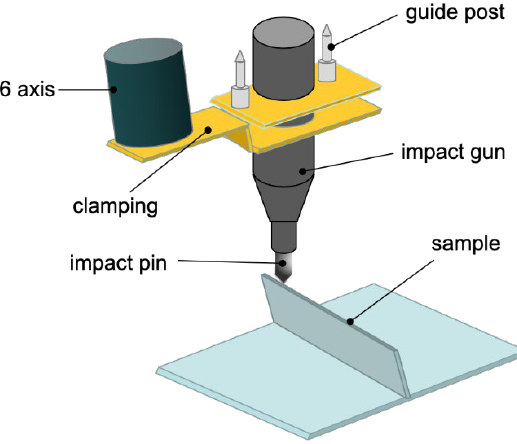
Figure 18. Schematic diagram of WAAM and hybrid ultrasonic peening.